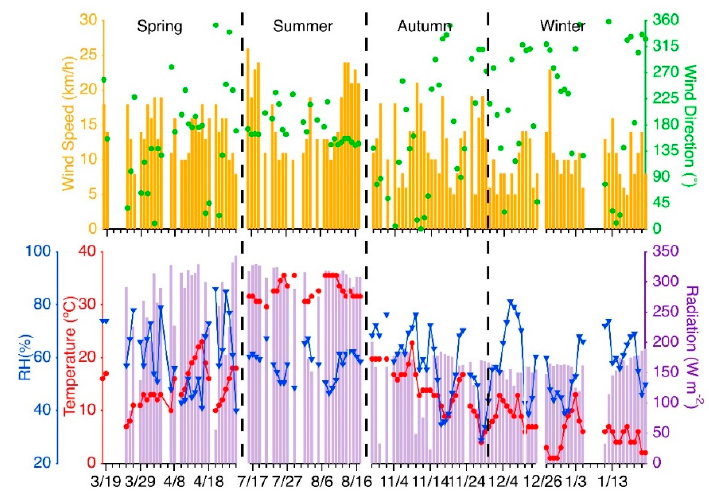
Figure 4. Meteorological conditions of Shanghai in 2013.